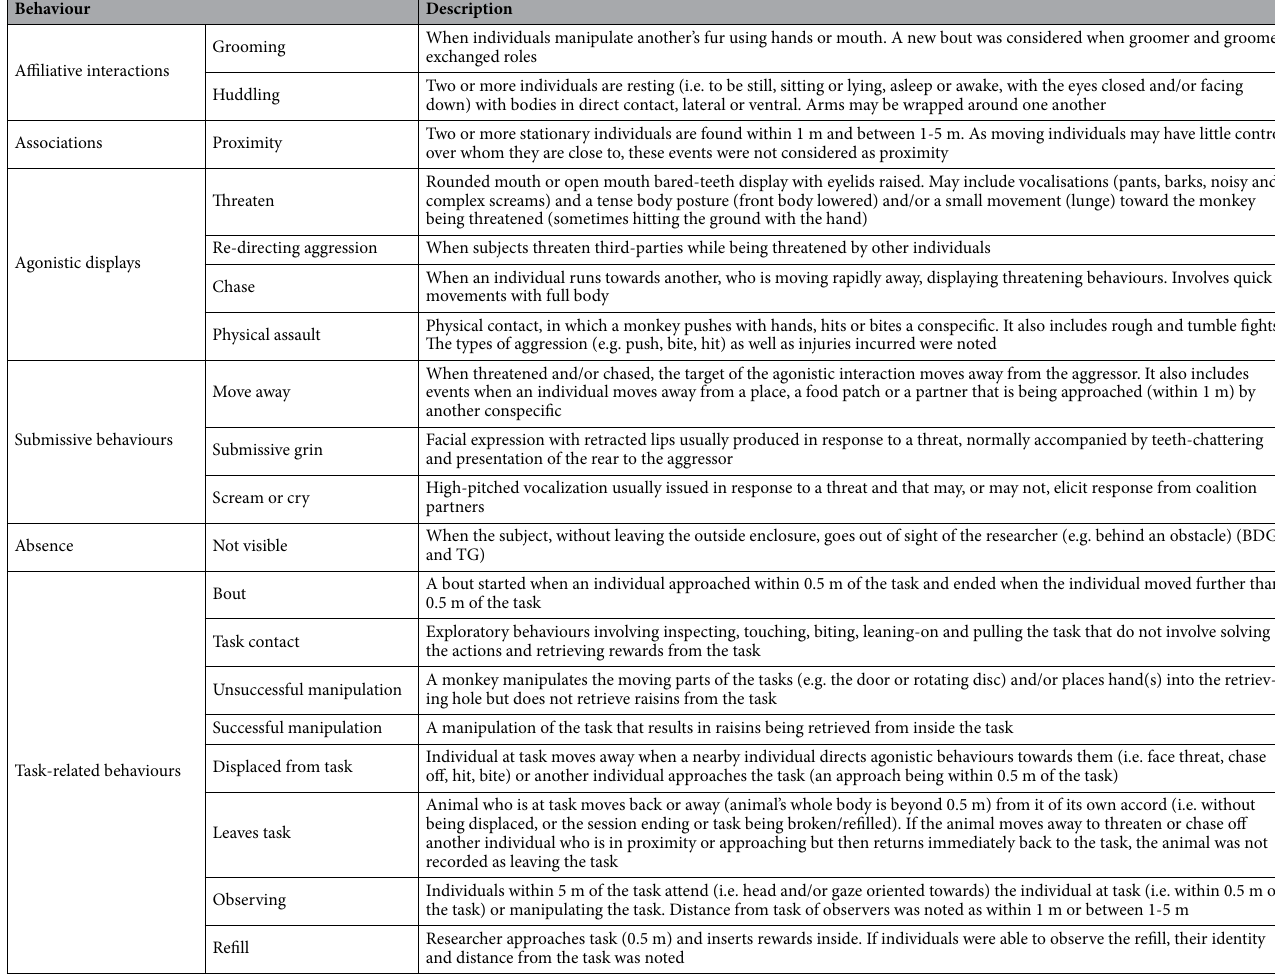
Table 1. Ethogram of socio-positive, agonistic and task-related behaviours of a group of Barbary macaques ( Macaca sylvanus ) at Trentham Monkey Forest